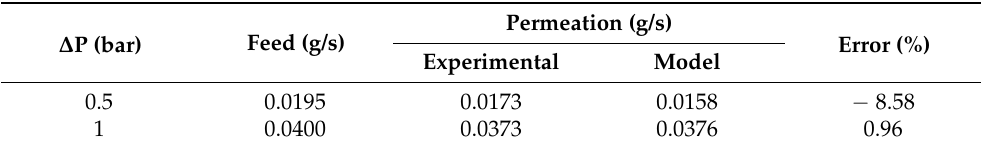
Table 3. Comparison of the experimental and predicted values of permeate flow for pure N 2 streams for different operating conditions with the PSS support.